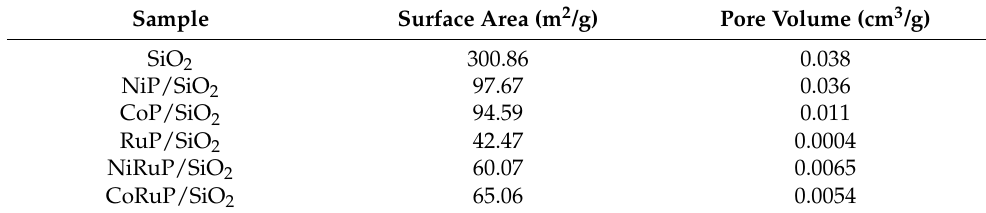
Figure 3. ( a ) Pore size distributions and ( b ) N 2 adsorption/desorption isotherms of samples. Table 1. Structural characteristics of the support and catalysts.